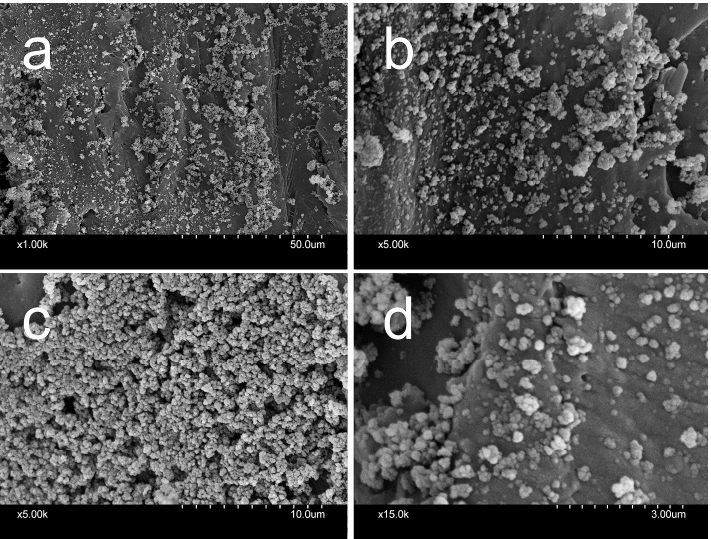
Figure 1. SEM images of the FSNP1.0-modified Scots pine wood in tangential section. ( a , b , d ): FSNPs deposited on cell wall surface, ( c ) the loose/porous structure of FSNP deposits on the cell wall surface. The discontinuous FSNP layer on the cell wall surfaces is the result of the low concen- tration of the FSNPs in the modifying suspension (1.5 and 2 wt.%). This meets the objective of keeping the amount of FSNPs in the wood low. The loose/porous structure of FSNP deposits is clearly shown in Figure 1c,d. Although the determination of the diameters of FSNP spheres is difficult, because they overlap in the image, a rough estimation of the globule size is 50 to 200